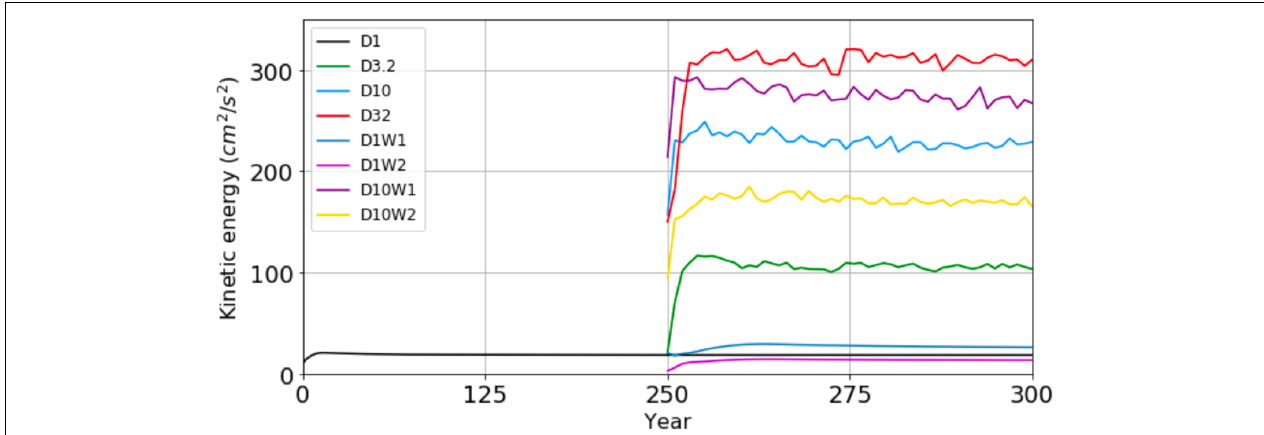
FIGURE 2 | Time series of domain-averaged kinetic energy above a depth of 1,000 m for all experiments.